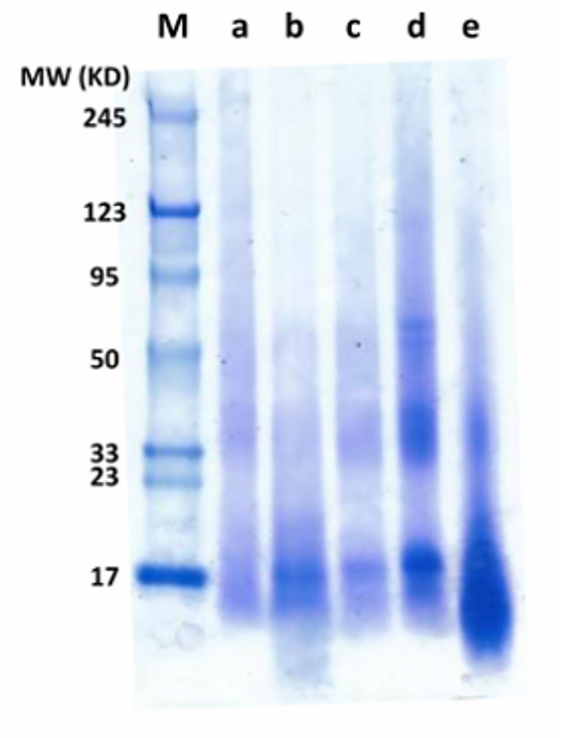
Figure 2. The molecular weight distribution of protein concentrates (protein concentration 0.5 w / w %). M: marker; a: BSG_pH; b: PG_pH; c: AP_pH; d: AP_H 2 O; e: